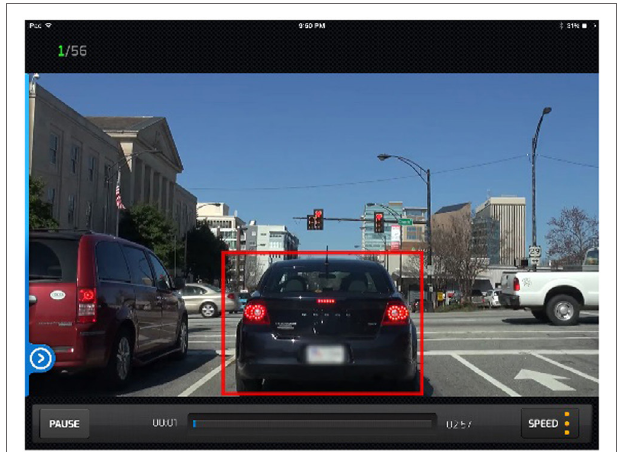
FigUre 1 | DriveFocus ™ interactive drive requires participants to touch the lights of the vehicle in front as well as the traffic lights. The lights of the leading vehicle should be